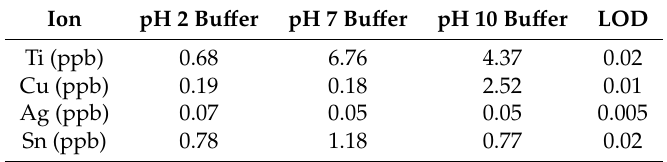
Table 3. ICP-MS analyses of the new bu ff er solutions and limits of detection (LODs).